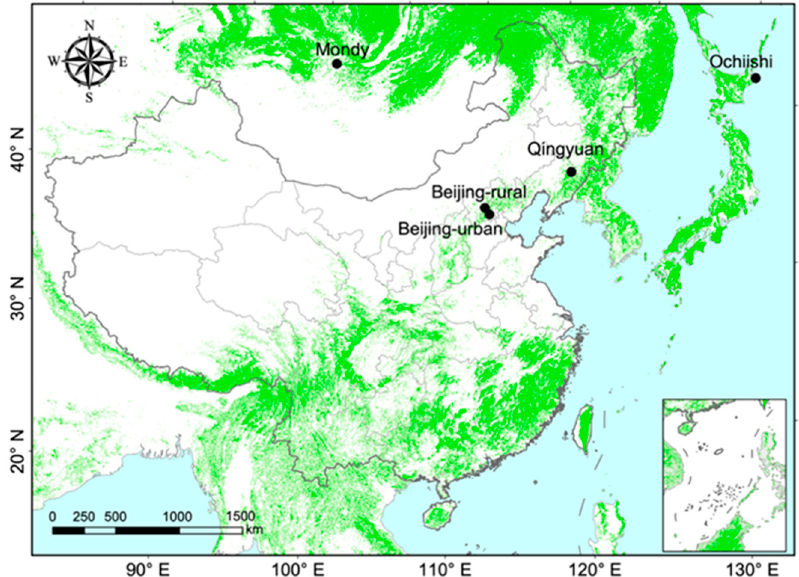
Figure 1. The locations of the Qingyuan forest study site and other sites with similar latitudes for comparison. Mondy in Russia and Ochiishi in Japan represent the clean interior and coastal sites, respectively. Beijing-urban and Beijing-rural in China represent the sites heavily influenced by urban and agricultural activities, respectively. The green areas indicate forest cover (URL: https://www.esa. int/ESA_Multimedia/Images/2018/09/2015_global_land_cover_map#.YWo7MMJQ1bU.link, ac- cessed on 18 October